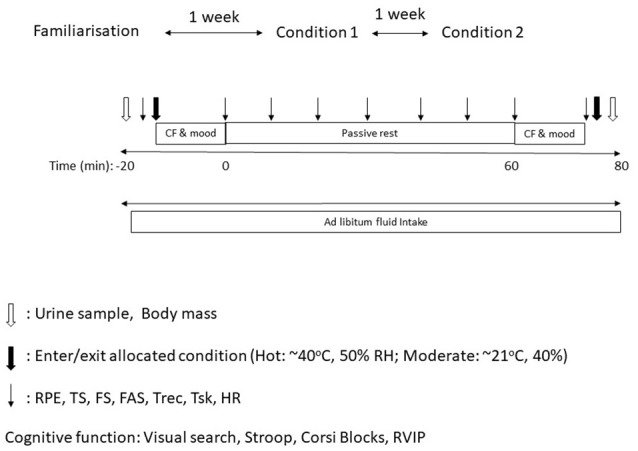
Protocol diagram.  Urine sample and body mass.  Enter/ exit allocated condition. ↓ RPE, TS, FAS, FS, Trec, Tsk, & HR.  CF & mood, cognitive function and mood questionnaire; RPE, rating of perceived exertion; TS, thermal sensation; FS, feeling scale; FAS, felt arousal scale; Tc, core temperature; Tsk, skin temperature.